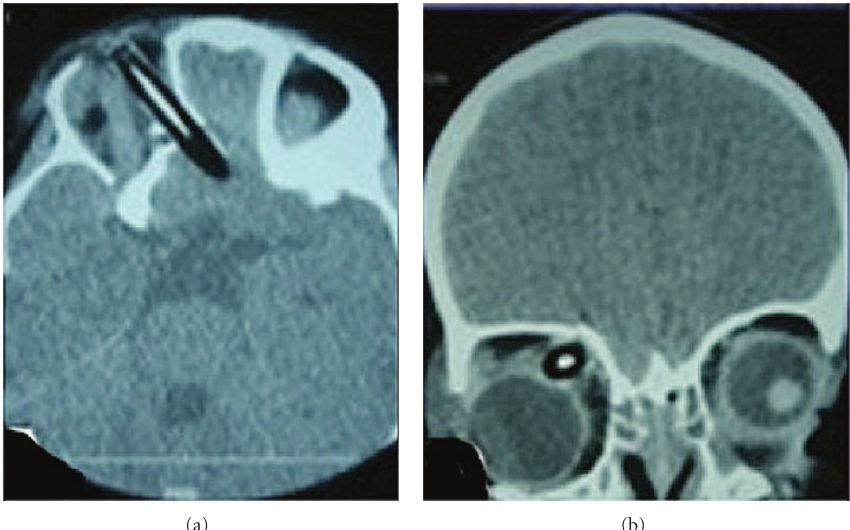
Figure 1: Computed tomography (CT) cranial scans demonstrating the foreign body penetration of the orbital wall (a) and downward displacement of the globe (b).